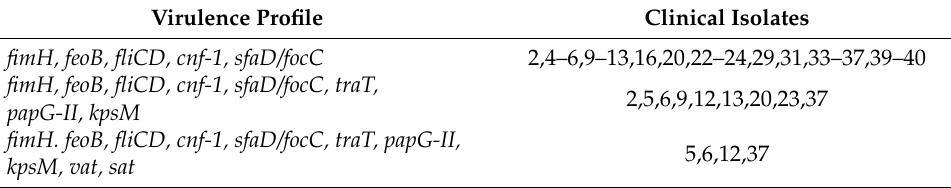
Table 4. Co-occurrence of virulence genes related with PAI in clinical isolates of UPEC.